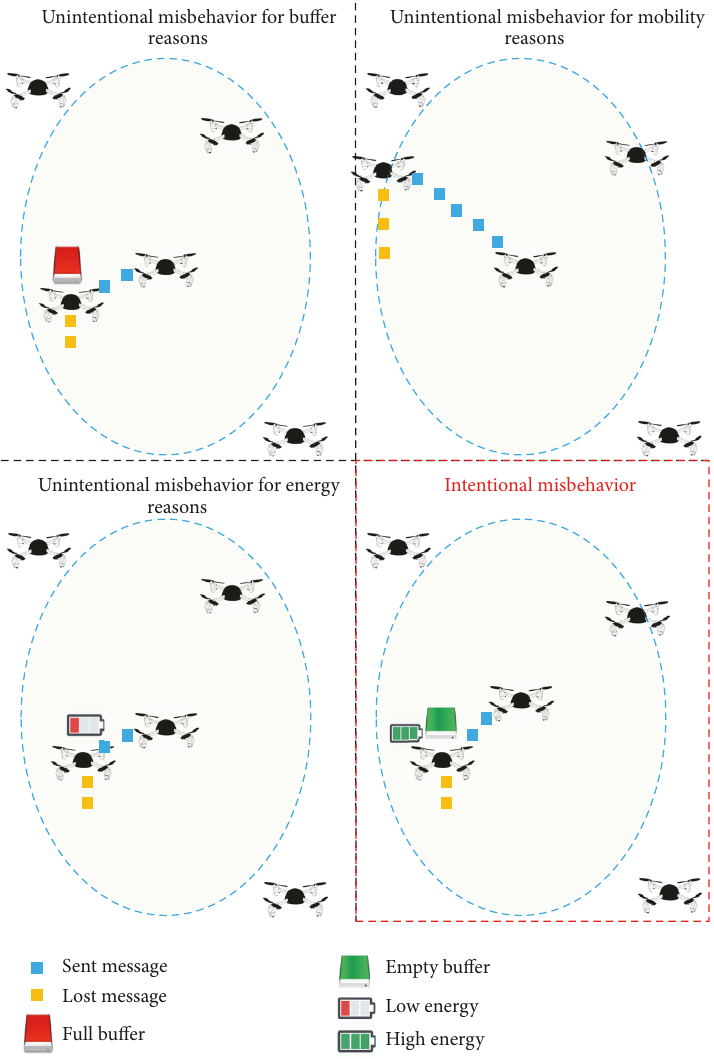
Figure 2: Intentional and unintentional